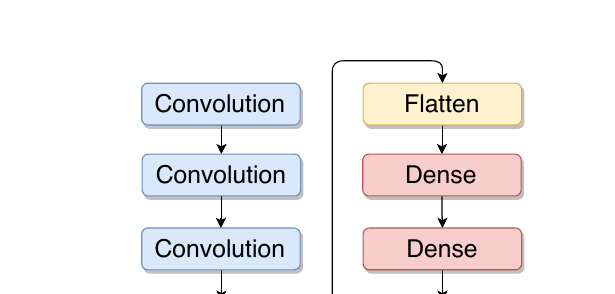
Figure 3. Basic convolutional block.